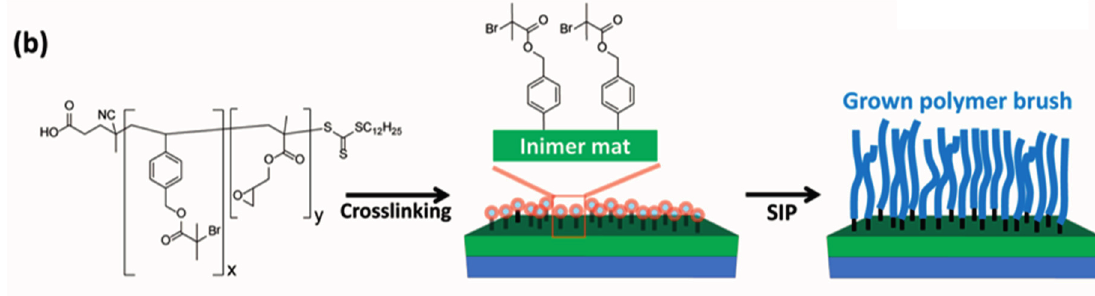
Figure 5. ( a ) Representative example of the use of catechol derivatives for initiator containing thin films [97–100,104]; and ( b ) Schematic illustration of the process for the formation of the initiator containing crosslinked thin film, followed by the brush growth (Reproduced with permission from Reference [106], Copyright 2014, American Chemical